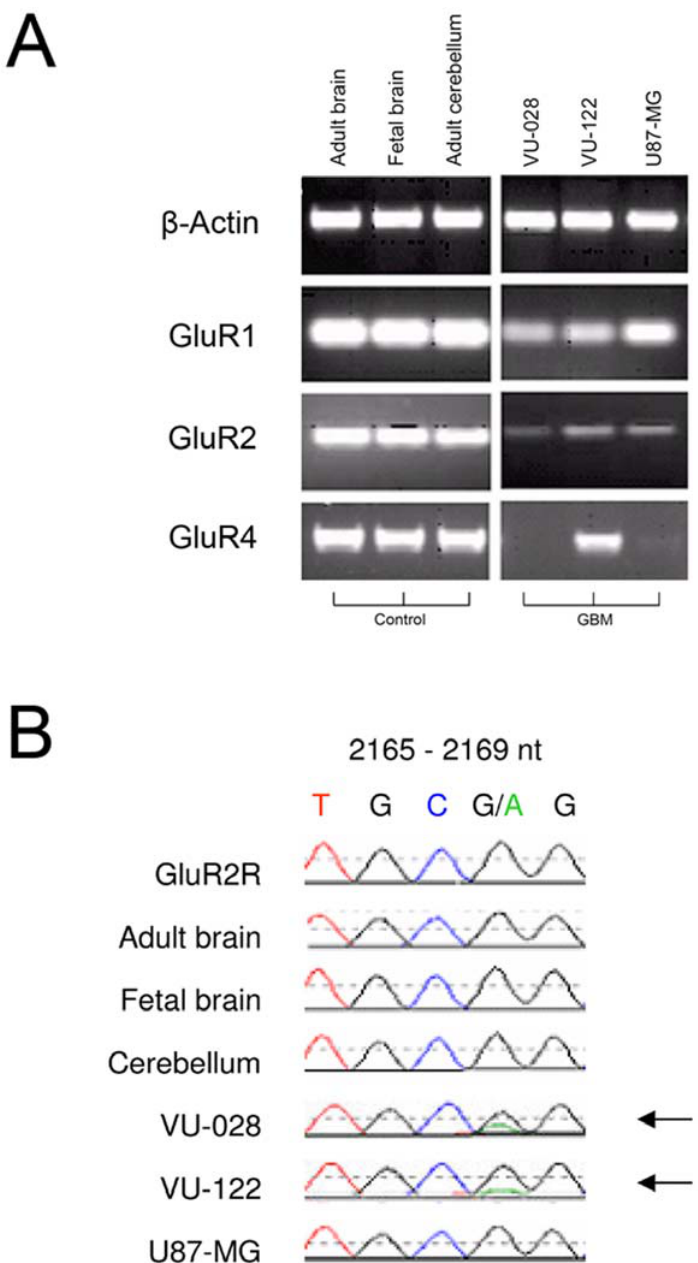
Figure 3. AMPAR mRNA expression in GBM cell lines. (A) RT-PCR of GluR1, 2 and 4 mRNA expression on primary VU-028 and VU-122 GBM cells and the established cell line U87-MG. (B) GluR2 PCR sequencing analysis. Posttransciptional RNA editing at the Q/R site in the second membrane domain (M2) of the GluR2 subunit. The glutamine (Q) codon (CAG) is substituted by an arginine (R) codon (CGG) by replacement of a single nucleotide, adenine to guanine, at position 2168. Adult and fetal brain, adult cerebellum, and glioblastoma cell line U87-MG express fully edited GluR2R (CGG). VU-028 and VU-122 express a combination of both GluR2R and unedited GluR2Q (CAG) subunits.